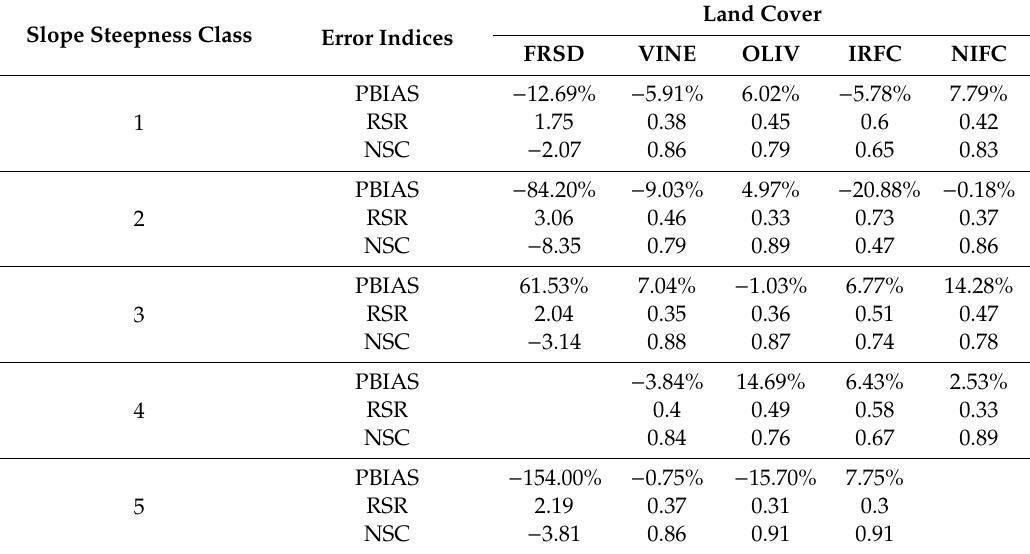
Table 5. Results for the statistical indices applied (percentage bias (PBIAS), ratio of the root mean square error to observation standard deviation (RSR), Nash–Sutcli ff e coe ffi cient (NSC)) for the